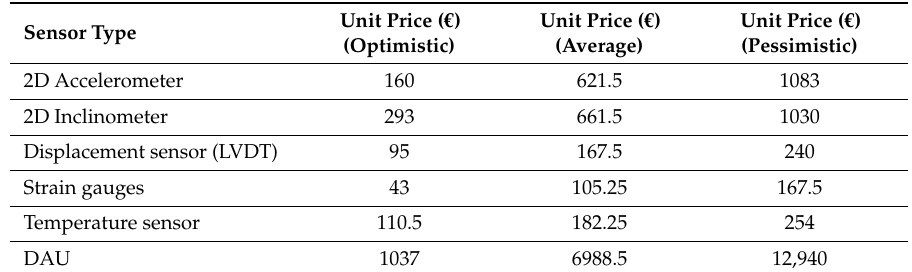
Table 14. Sensitivity analysis of hardware price.